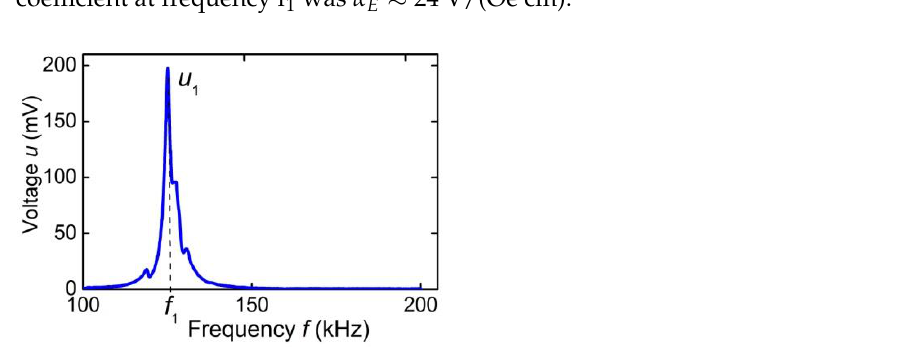
Figure 20. Dependence of the ME voltage u on the excitation current frequency f for the Cu/Metglas-PZT-Metglas/Cu heterostructure at H = 25 Oe.